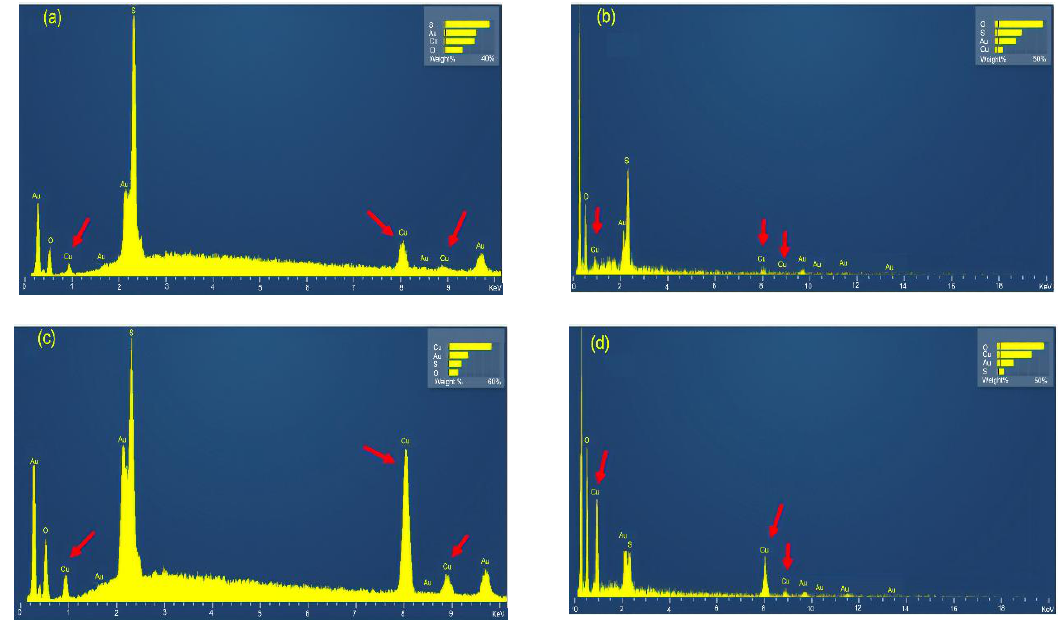
Figure 4. EDS of wool@HKUST-1 synthesis of: ( a ) 24 h; ( b ) 24 h washed; ( c ) 48 h; and ( d ) 48 h washed.